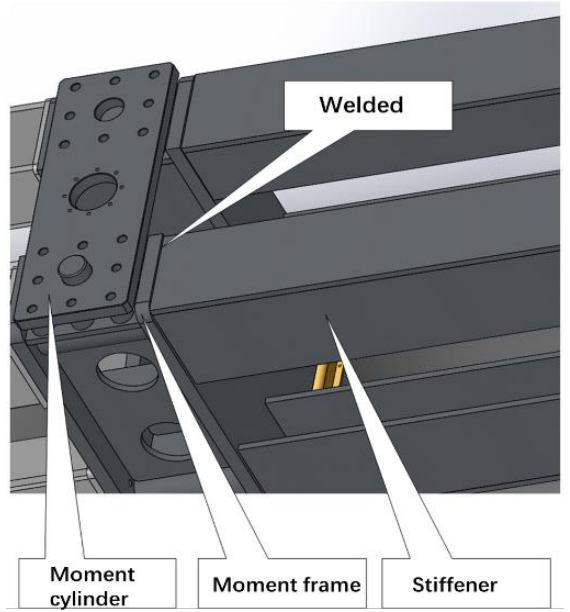
Figure 4. Connection form of the middle frame joint.